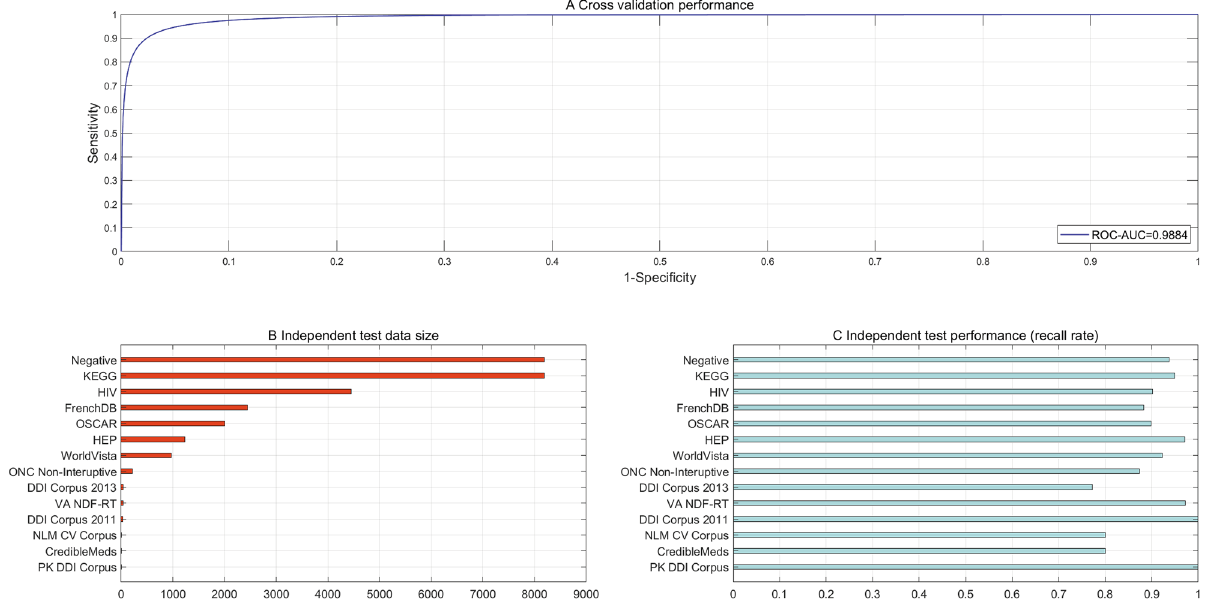
Figure 1. Performance of cross validation and independent test. ( A ) ROC curve and AUC score for fivefold cross validation. ( B ) Statistics of independent test data size. ( C ) Recall rates on the independent test data. Cross